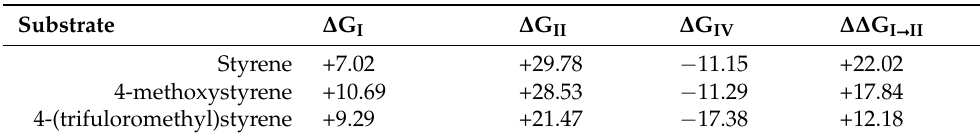
Table 2. Gibbs free energies (in kcal/mol, relative to separated substrates) in the activation of different styrenes.